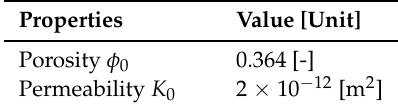
Figure 6. Left : Problem setup; right : Initial and boundary conditions for the simulated problem. Table 5. Porous medium properties for the simulated